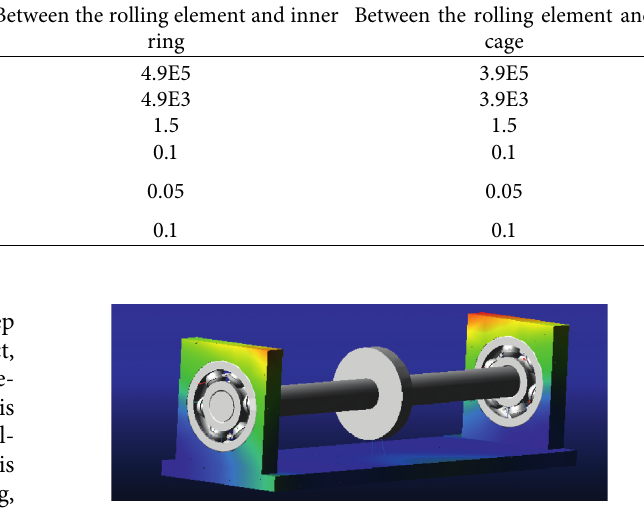
Figure 5: Dynamic simulation of the rolling